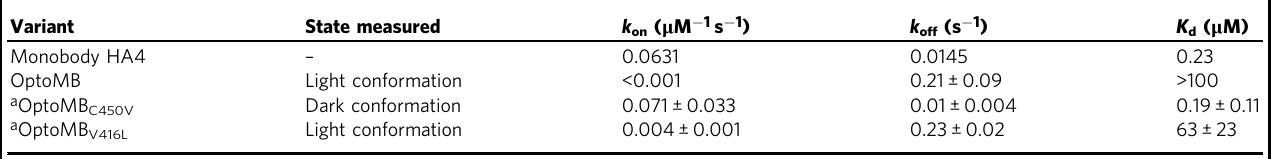
a Average of three individual